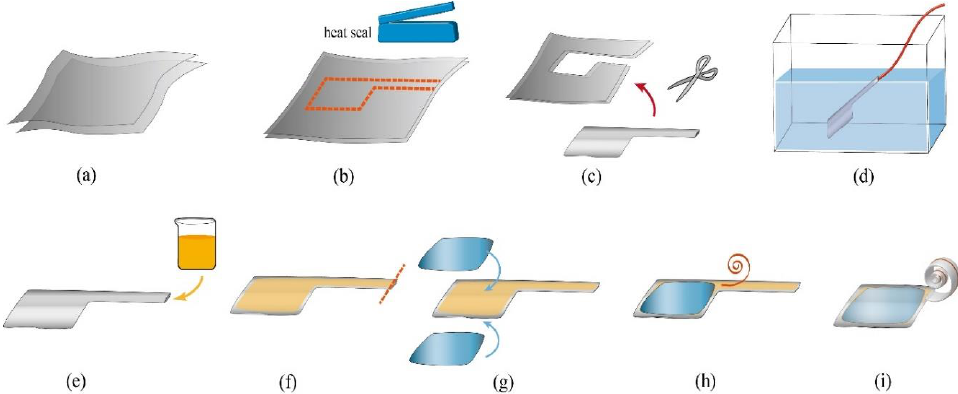
Figure 6. The fabrication of the bio-inspired spiral proboscis actuator (BSPA) actuator. ( a ) Two thin low-density polyethylene (LDPE) films were prepared. ( b ) The pattern was drawn on the LDPE film, and marked with Kapton tape. The Kapton tape serves as a marker and protection for the areas we do not want the heat to affect. The heat seal process was done using a commercial heat seal machine. ( c ) After heat sealing, the extra LDPE film was then cut away from the actuator. ( d ) The device was submerged under water to test the air-tightness of the seal. ( e – f ) The actuator was taken out of the water, allowed to dry, and filled with dielectric liquid. ( g ) After heat sealing the opening of the tube, the electrodes were attached on the top and bottom of the pouches. ( h ) The PET spring was attached to the tube by tape. ( i ) The final device.